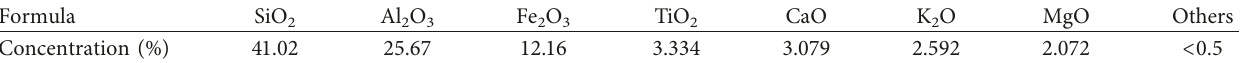
Table 3: XRF analysis of Liapor.